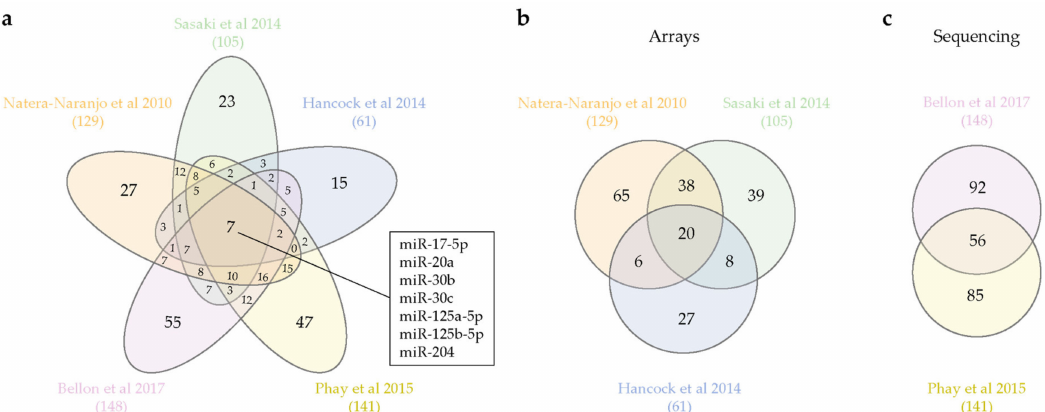
Figure 1. Axonal miRNAs shared among datasets. ( a ) Venn diagram of all axonal miRNAs profiling. Seven miRNAs are shared by all datasets, and names are reported in the box. ( b ) Venn diagram of profiling obtained by miRNAs microarray [38] or TaqMan RT-qPCR arrays [39,40]. ( c ) Venn diagram of miRNAs shared between sequencing datasets. Total number of axonal miRNAs are reported in parenthesis below the references. Venn diagrams are obtained with an open access software [47].